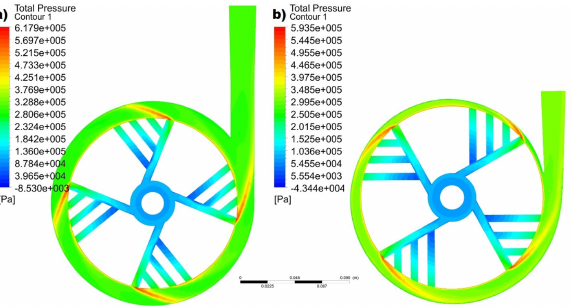
Figure 19: Distribution of total pressure on the model central plane